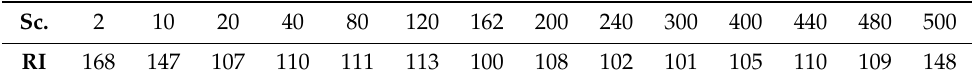
Table 3. Strategy by Scenarios between 2 and 500 (Sc.).